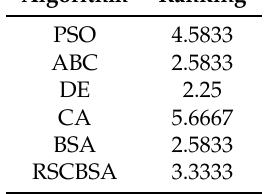
Table 4. Average Rankings of the algorithms (Friedman) on multimodal benchmark functions.